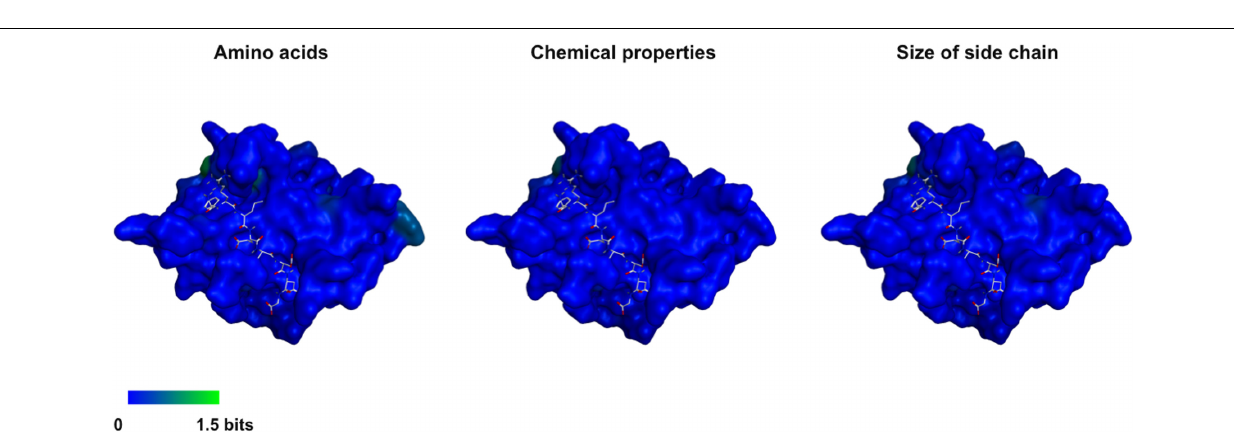
Frontiers in Microbiology |